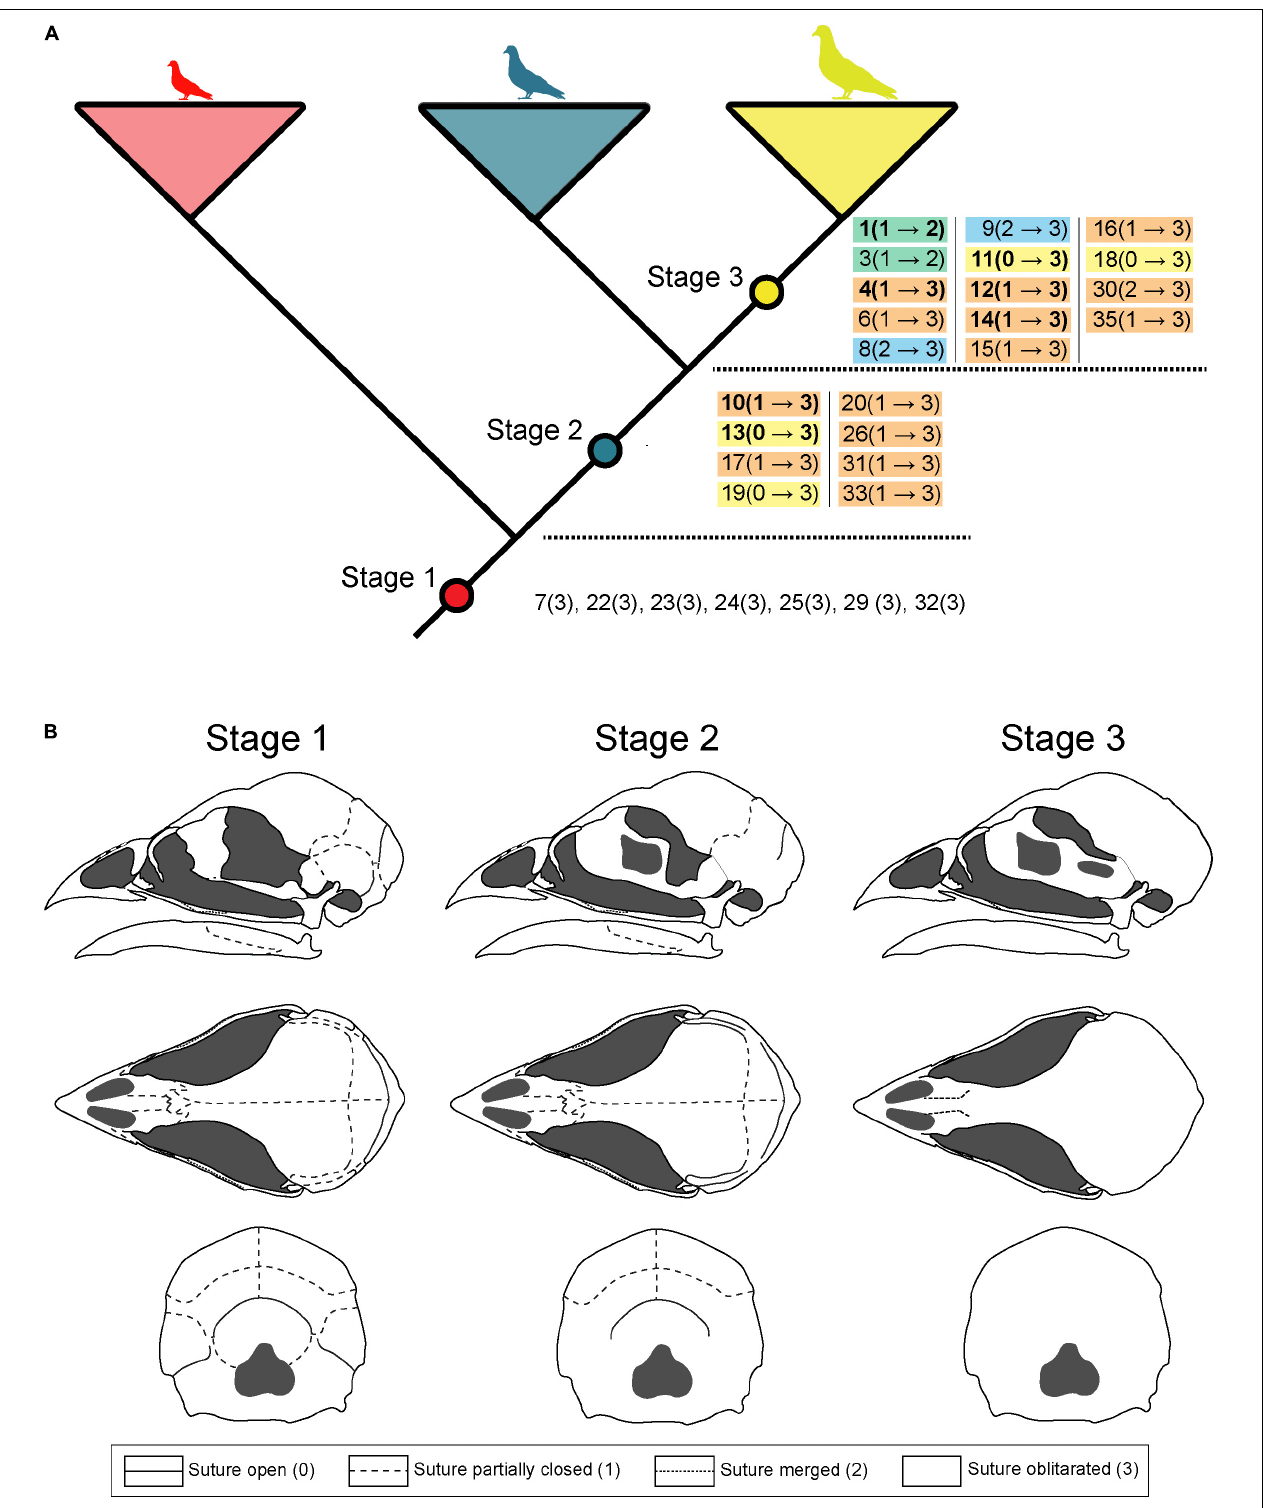
FIGURE 6 | Sequence of ontogenetic bone fusions. (A) Main ontogenetic changes of sutural closure in birds skulls between the three ontogenetic stages. Different colors correspond to the number of steps of fusion characters happen between two ontogenetic stages. Ontogenetic changes of the orbital region (Green and Gignac, 2020) are shown in bold. (B) Illustration of the major changes in sutural closure in the chicken Gallus gallus during ontogeny (chicken skull modified from Jollie, 1957).